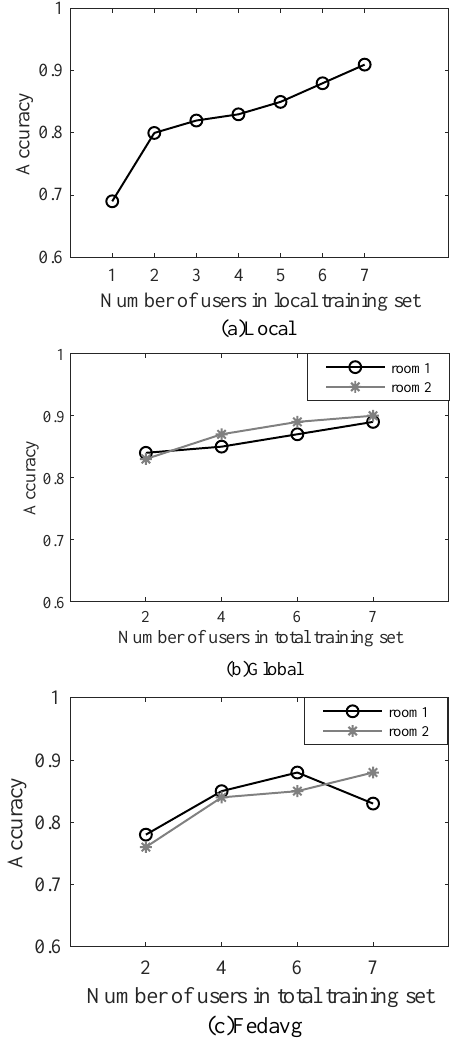
Figure 3. Different method